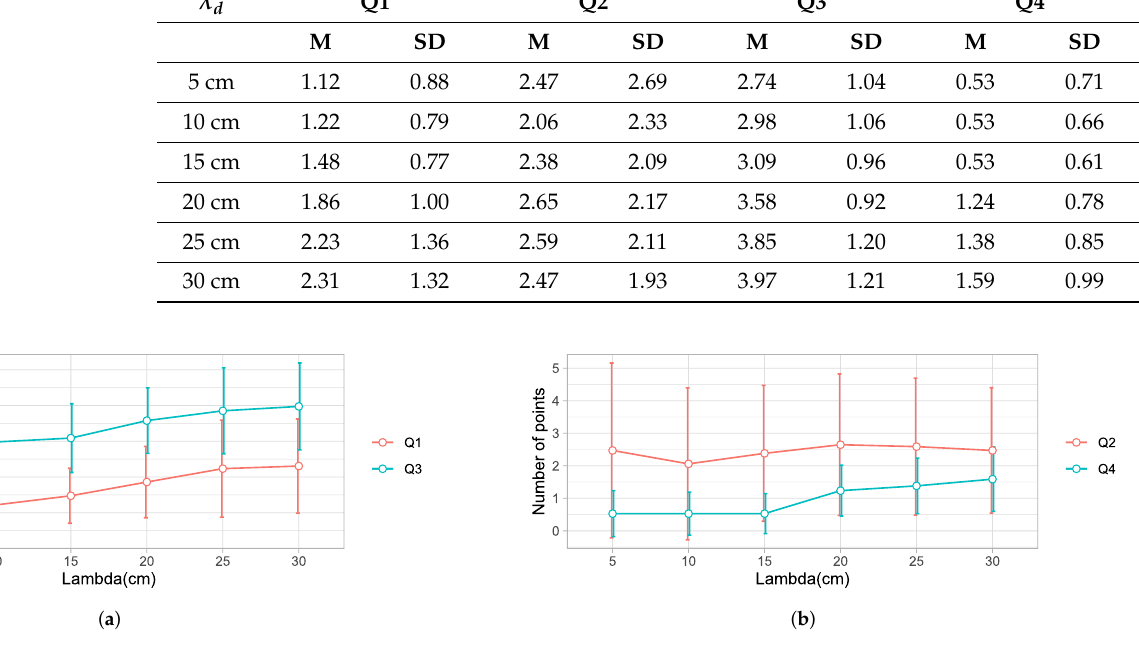
Figure 14. Results for each value of the hand threshold. ( a ) Q1: The time taken by the strategy to detect the desired point. Q3: The time taken by the robot to reach the desired point. ( b ) Q2: The number of intermediate points detected by the strategy. Q4: The total number of intermediate stopping points of the